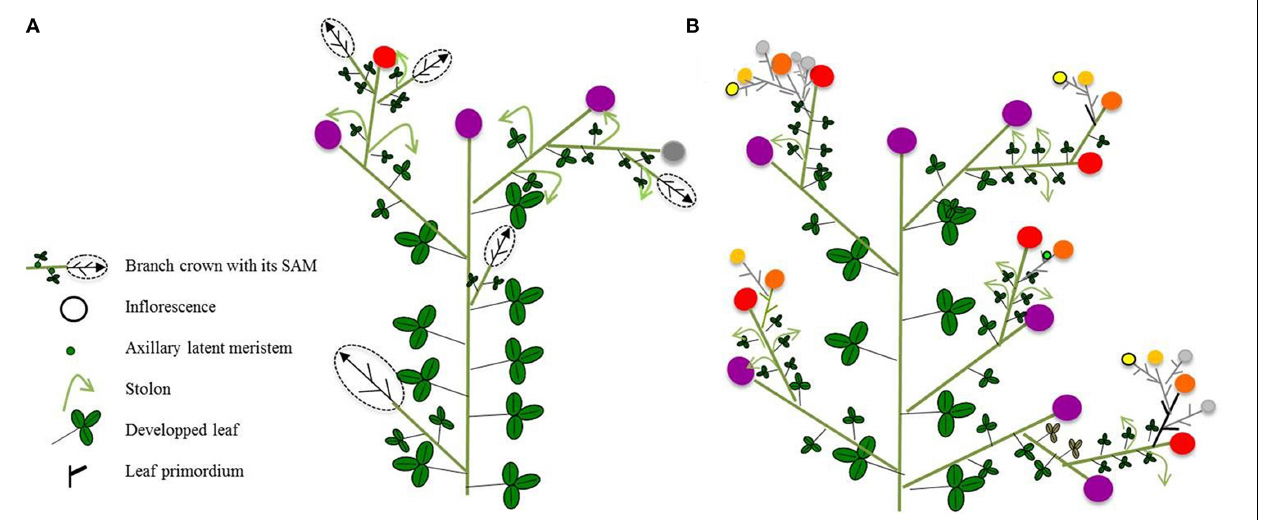
FIGURE 5 | Architecture of a strawberry plant. (A) for a once flowering genotype, in which axillary meristems will develop into runners or branch crowns and (B) for a perpetual flowering genotype, in which axillary meristems will develop into new inflorescences. The color of inflorescence reflects its stage: purple when already